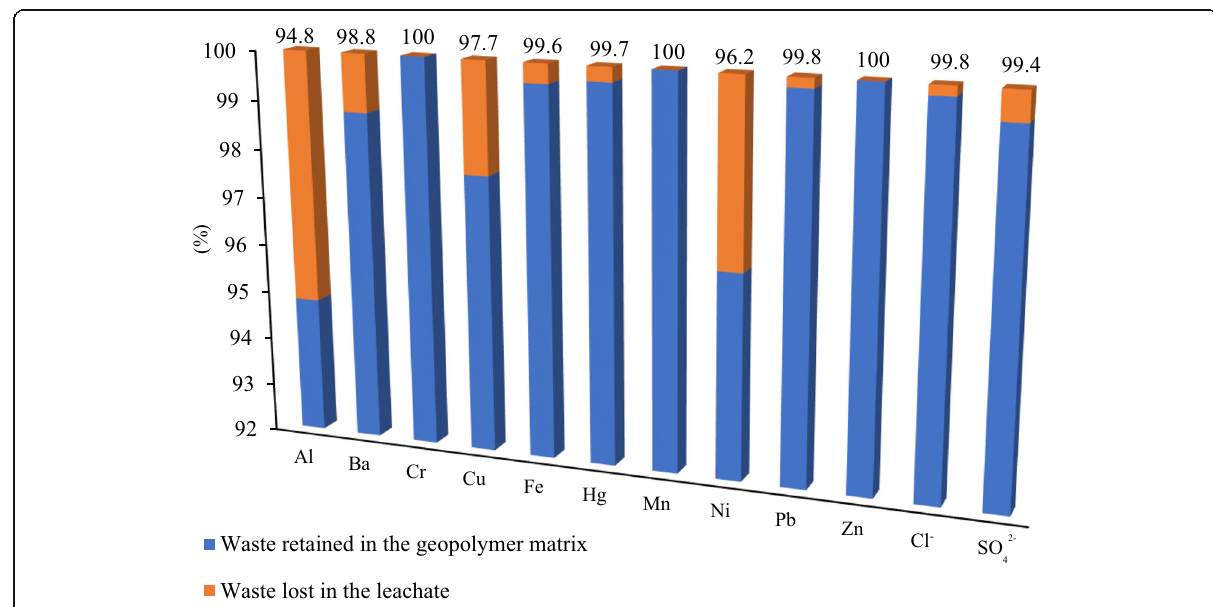
Fig. 5 Graphical representation of waste retention at 7 months after geopolymerization. Total waste retained confirmed via